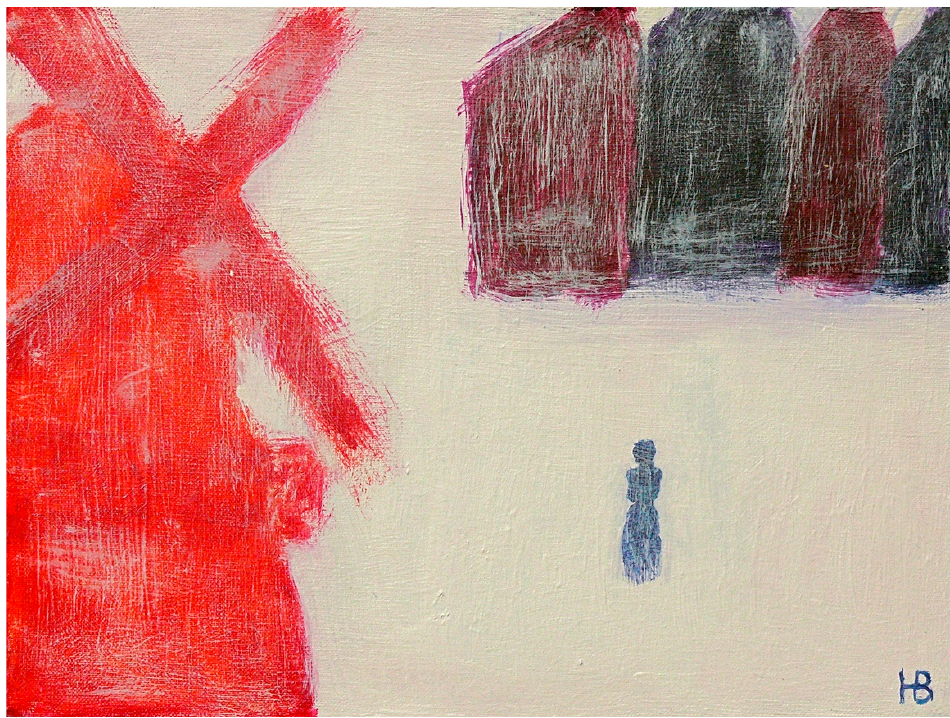
Figure 2. Hannah Bischof, “ Die rote Mühle ”, acrylic on canvas, Berlin 2012, © Ben